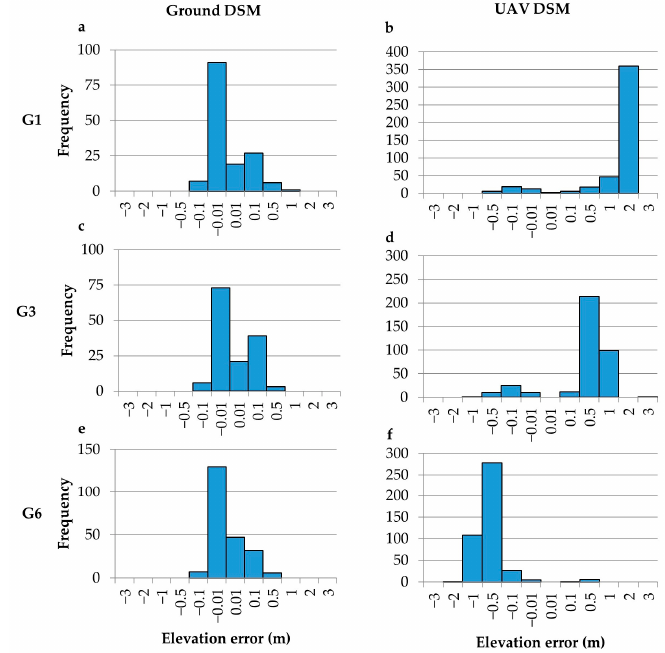
Figure 5 . Distribution of elevation error (m) between RTK validation points and: ( a , c , e ) Ground DSM; and ( b , d , f ) UAV DSM, for G1, G3, and G6, respectively.